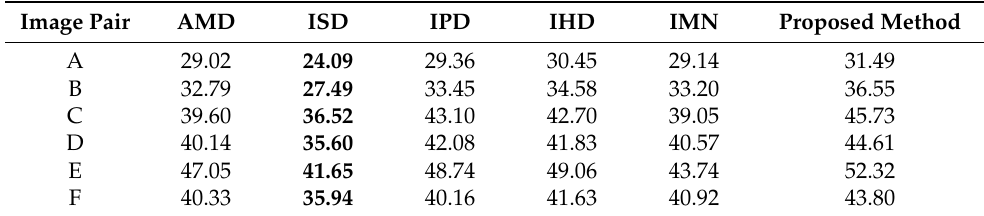
Table 6. The total test time (the unit is second) of the AMD, ISD, IPD, IHD, IMN, and proposed method based on six groups of stereo images. Bold font denotes the best results.